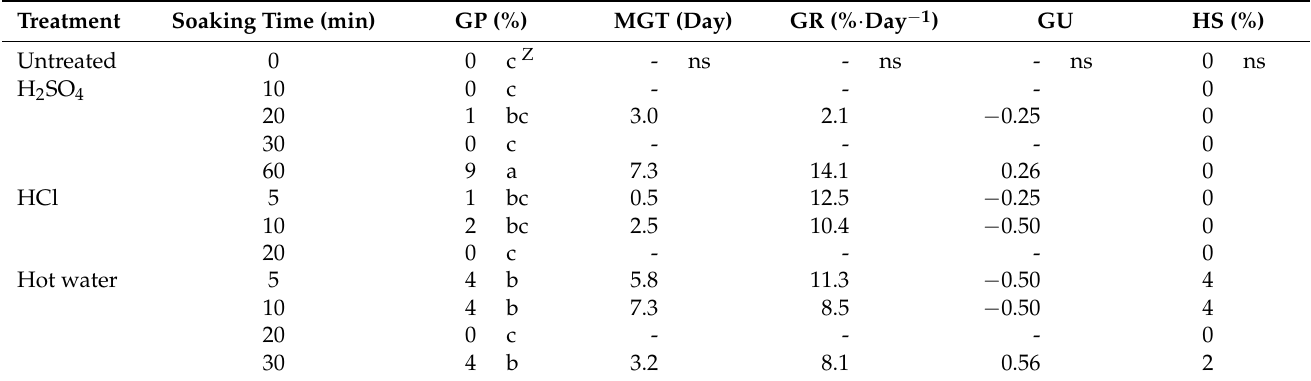
Table 1. Effects of 95% H 2 SO 4 , 37% HCl, and hot water (70 ◦ C) treatment on the germination percentage (GP), mean germination time (MGT), germination rate (GR), germination uniformity (GU), and healthy seedlings percentage (HS) of A. sikokianus seeds.